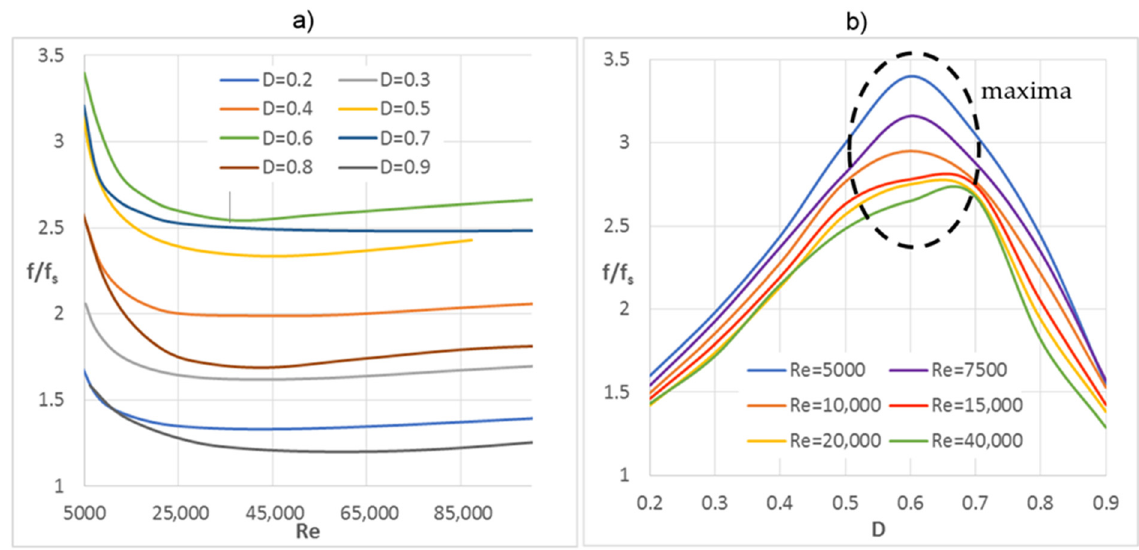
Figure 8. ( a ) f / f s ( Re ) ratio for dimensionless insert diameters D ; ( b ) f / f s ( D ) ratio for several Re numbers.